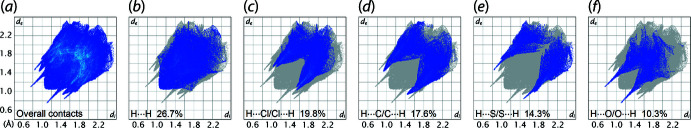
(a) The full two-dimensional fingerprint plot for (I) and fingerprint plots delineated into (b) H⋯H, (c) H⋯Cl/Cl⋯H, (d) H⋯C/C⋯H, (e) H⋯S/S⋯H and (f) H⋯O/O⋯H contacts.